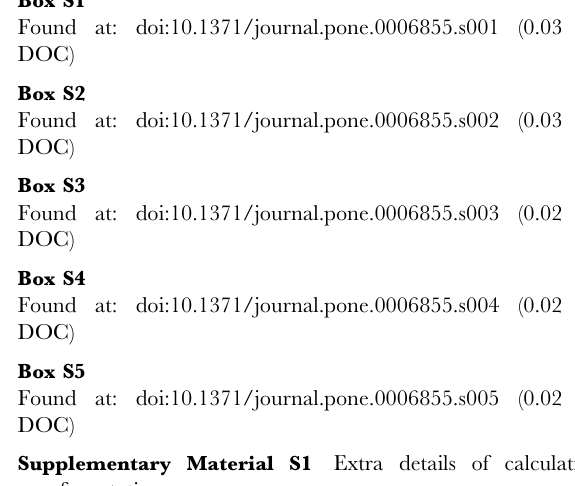
Figure S1 A comparison of approximations to the non-spatial SIR model with initial conditions ( S,I,R )=(480,20,0) and common parameters R 0 ~ b = v ~ 2 and v ~ 2 . The error-bars denote standard errors from 500 replicates; ‘Taylor’ denotes the approximation developed in Section 3 of Results; and ‘moment closure’ the result from zero third cumulant closure.